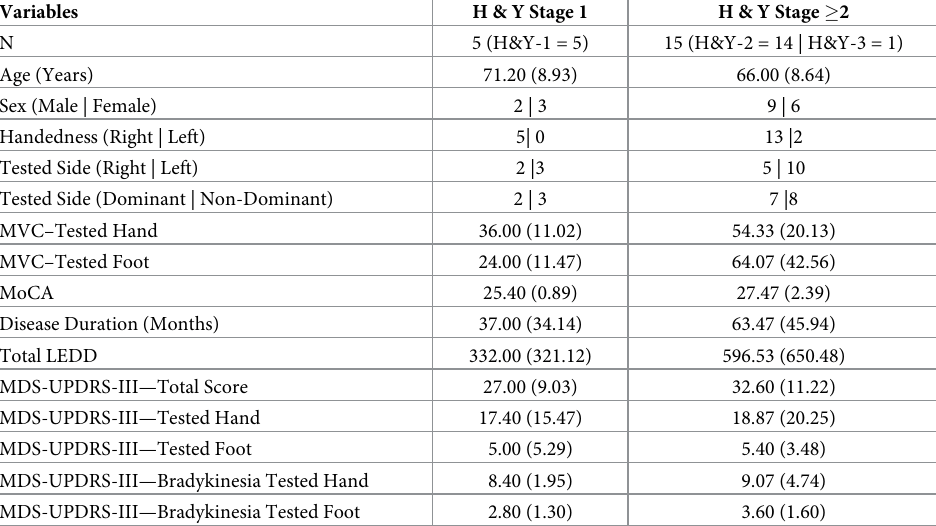
The table lists the sociodemographics, clinical characteristics and several behavioral measures for the PD patients group by the Hoehn and Yahr stage. Data are count or mean ± 1 standard deviation (SD). Abbreviations: HY = Hoehn and Yahr Staging Scale; LEDD = levodopa equivalent daily dose; MoCA = Montreal Cognitive Assessment; MDS-UPDRS-III = the motor section of the Movement Disorder Society Unified Parkinson’s Disease Rating Scale; mg = milligram; MVC = maximum voluntary contraction; N =